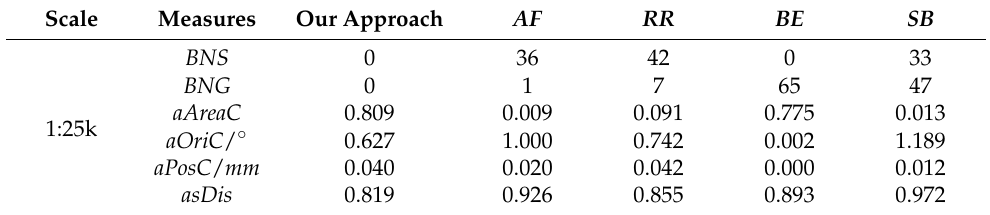
Table 4. Comparison of results obtained based on our approach and other simplification